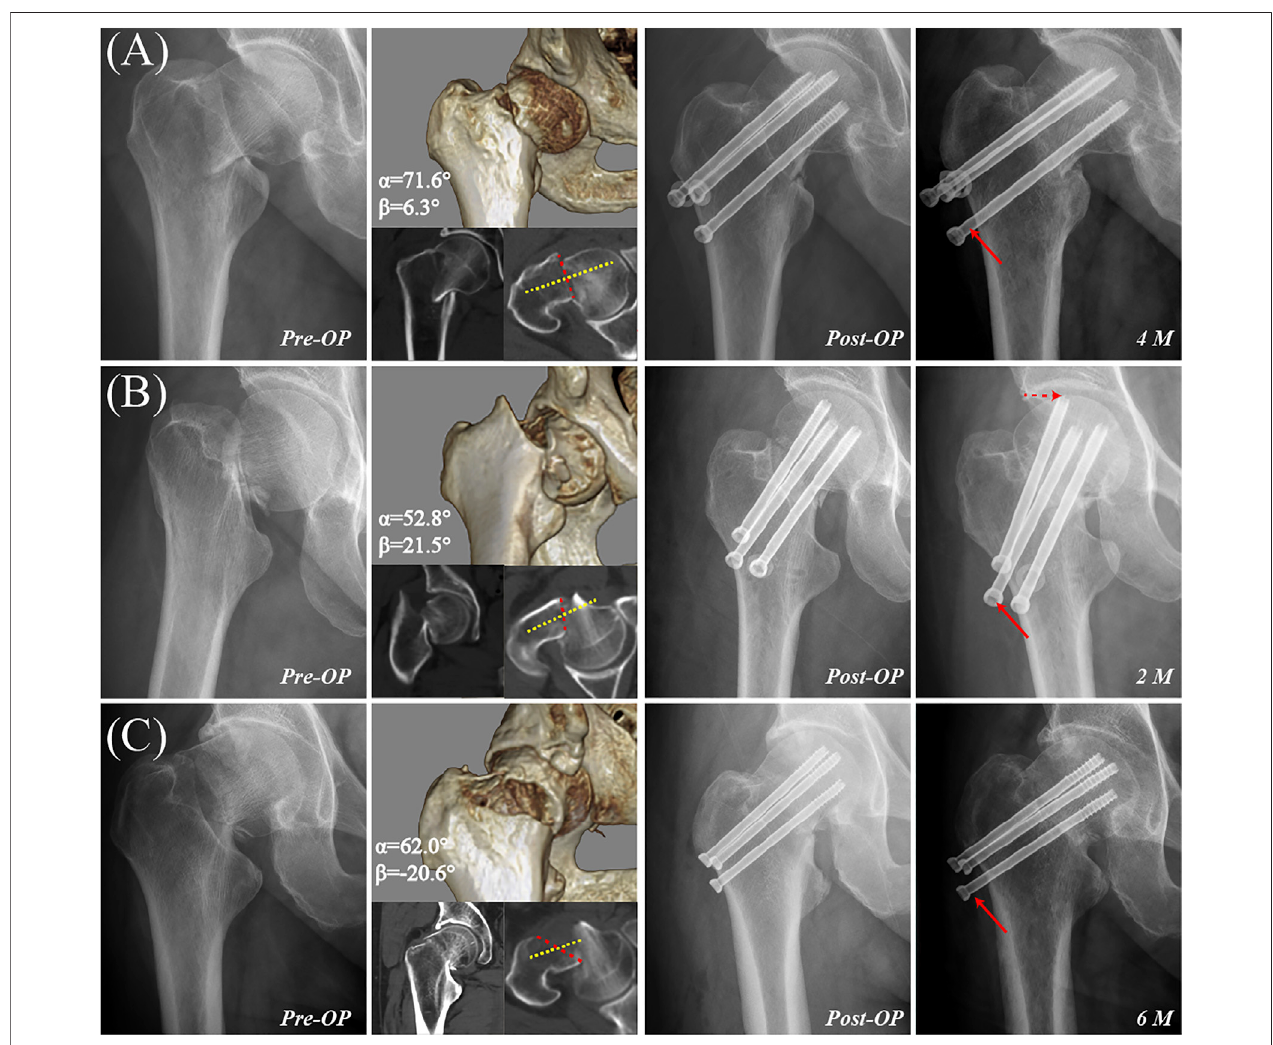
FIGURE 5 | Examples of femoral neck fractures with 3-D unstable inclination angle. (A) A 46-year-old male with a vertical unstable inclination angle ( α (cid:1) 71.6 ° and β (cid:1) 6.3 ° ) was treated with three cannulated screws. Radiography taken 4 months postoperatively revealed severe screw withdrawal (red arrow) as well as femoral neck shortening,varuscollapse,anddelayedunion. (B) A46-year-oldfemalewithretroversionobliqueunstableinclinationangle( α (cid:1) 52.8 ° and β (cid:1) 21.5 ° )wastreatedbythree cannulated screwswith a fairreductionquality. Radiography taken 2 months postoperatively revealed severe screw withdrawal (solid red arrow) as well as femoral neck shortening, varus collapse, screw penetration of the joint capsule (dotted red arrow), and delayed union. (C) A 59-year-old male with anteversion oblique unstable inclination angle ( α (cid:1) 62.0 ° and β (cid:1) − 20.6 ° ) was treated with three cannulated screws. Radiography taken 6 months postoperatively revealed severe screw withdrawal (red arrow) as well as femoral neck shortening, varus collapse, and delayed union.